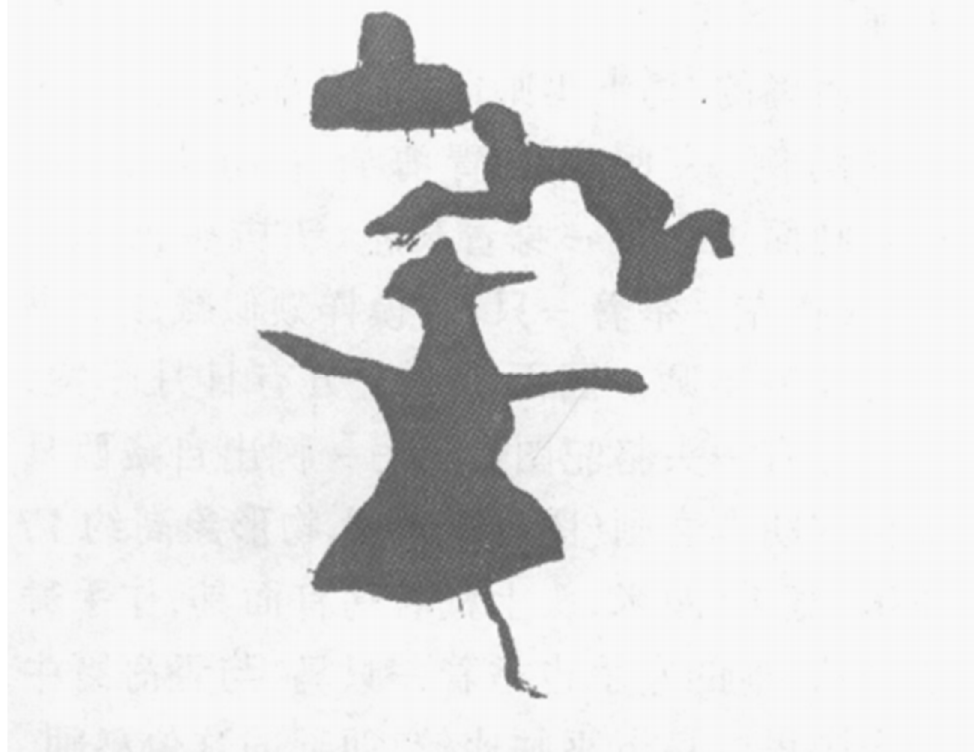
Figure 1. People worship at an altar wearing the representative of the original Bön 苯教 shaman of the bya-ru 甲茹 (rock painting from Zhaxi Island, Namucuo, northern Tibet 纳木错扎西岛 ) (Zhang 2006, p. 55).